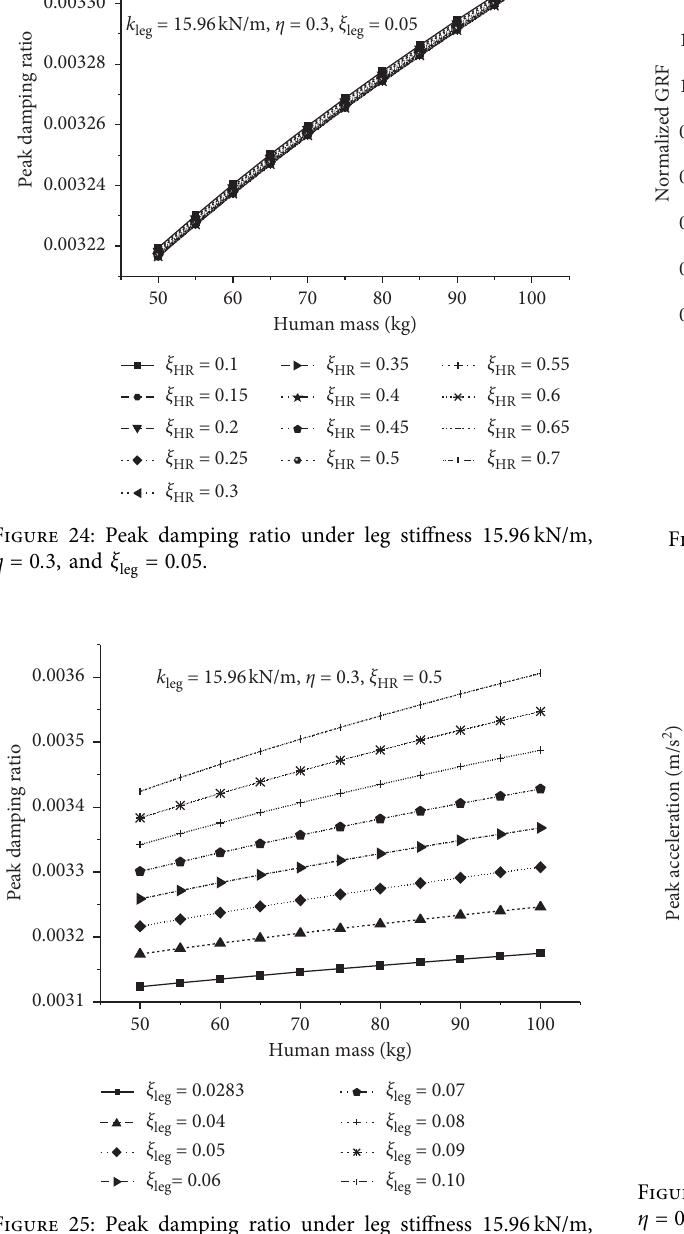
Figure 25: Peak damping ratio under leg stiffness 15.96kN/m, � 0 . 5. η � 0 . 3, and ξ HR